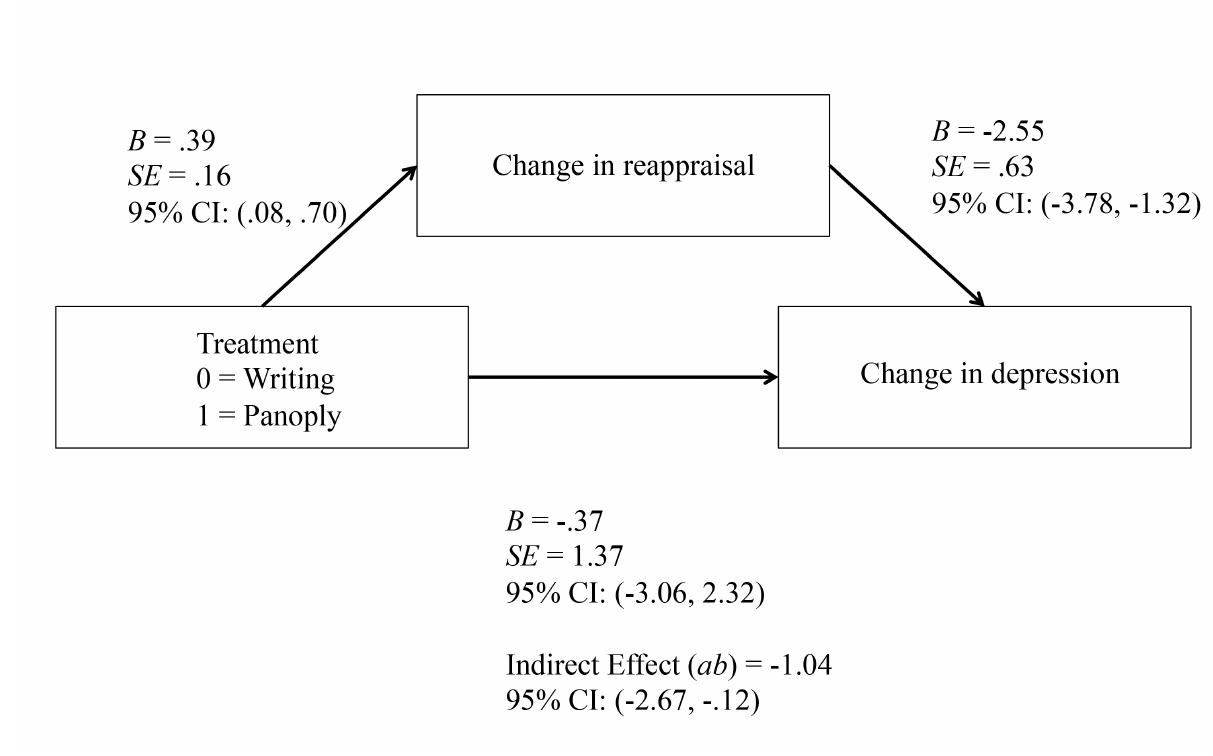
Figure 5. Mediation of change in reappraisal on change in